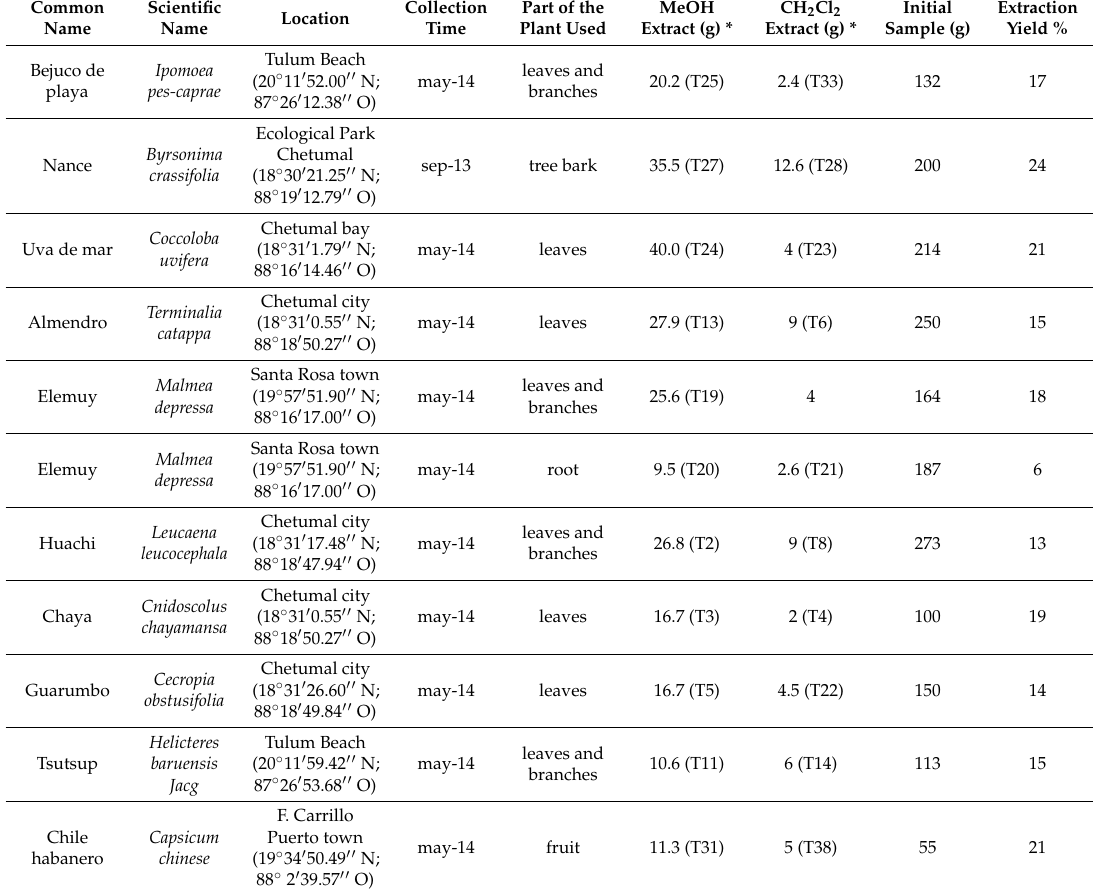
Table 1. Plant collection: general plant information, and extract production